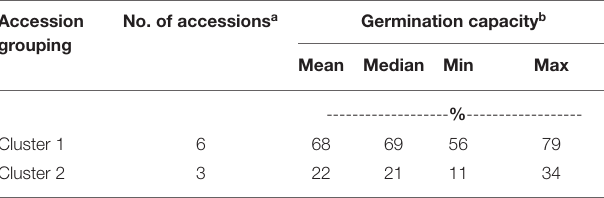
FIGURE 5 | Castellation plot showing two clusters of E. crus-galli from Arkansas, USA based on germination capacity. The accessions were grown in a common garden in Fayetteville, Arkansas. Seeds were after-ripened for 180 d at 25 ◦ C and germinated in a growth chamber at 32 ◦ C day/23 ◦ C night temperature with 12-h photoperiod. Cluster 1 = green; Cluster 2 = red. TABLE 6 | Germination capacity of Echinochloa crus-galli in Arkansas, USA, averaged across accessions in a